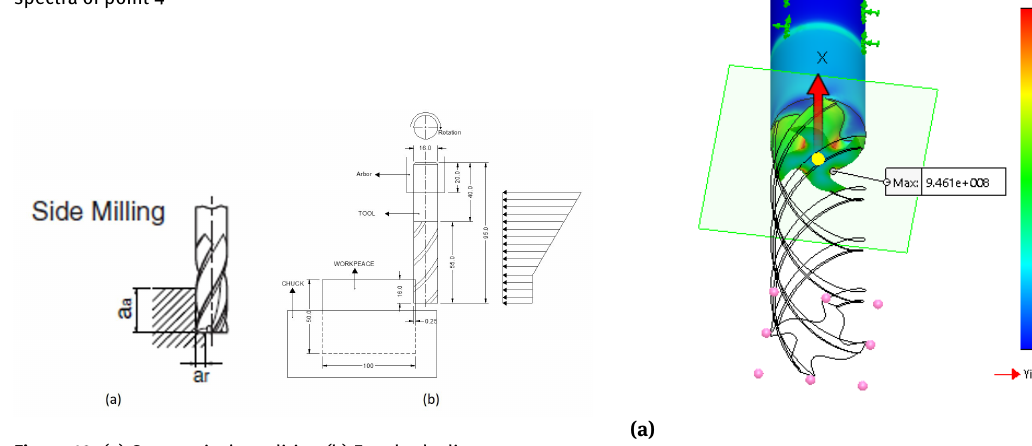
Figure 9: EDS analysis of used end mill at the surface adapted to the surface of fractured end mill (a) points EDS, (b) EDS spectra of point 1, (c) EDS spectra of point 3, (d) EDS spectra of point 2, (e) EDS spectra of point 4